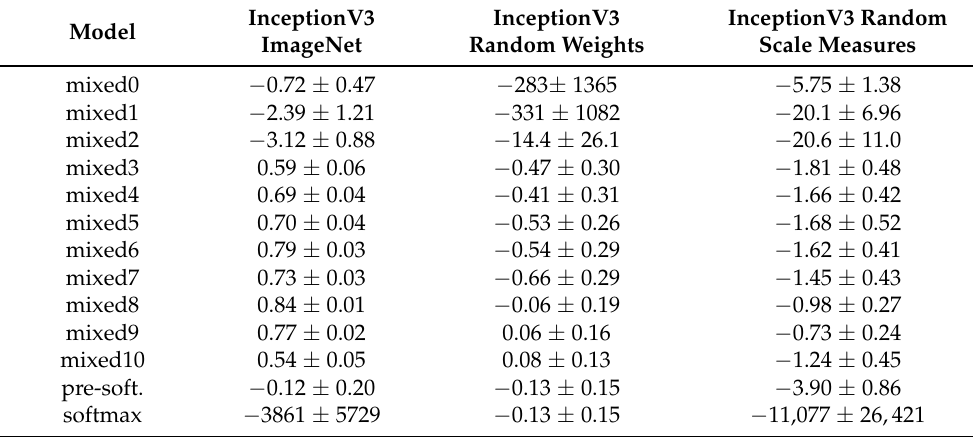
Table A1. Details of R 2 of scale measure displayed in Figure 8a. Average of the R 2 and standard deviation across 25 runs with InceptionV3 on the albatross class. Model